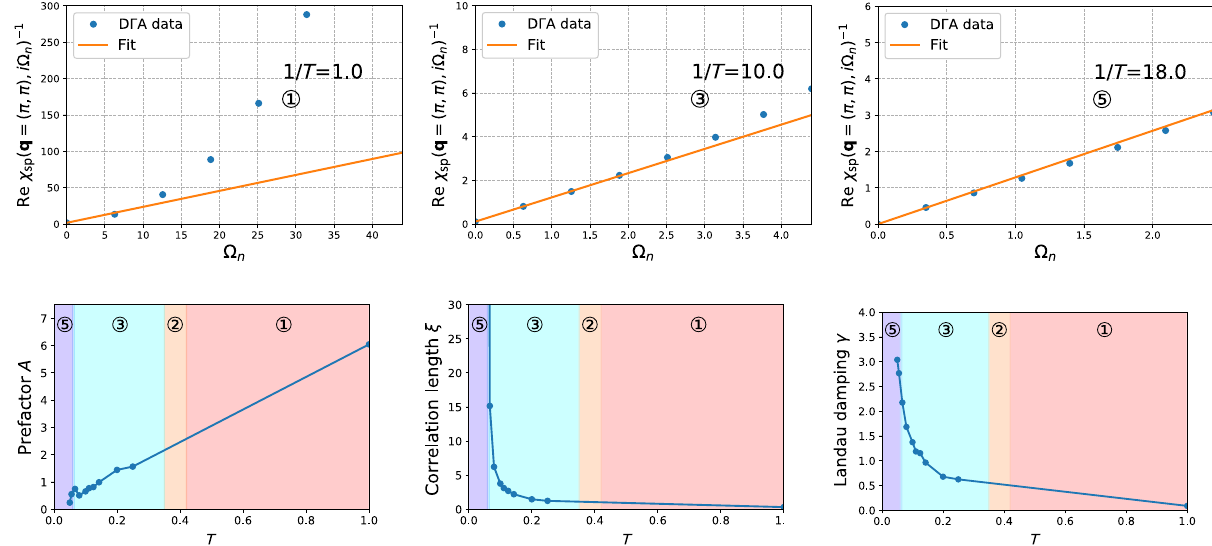
; π Þ (third row) and q ¼ ð q ; q (lowest x x x Þ